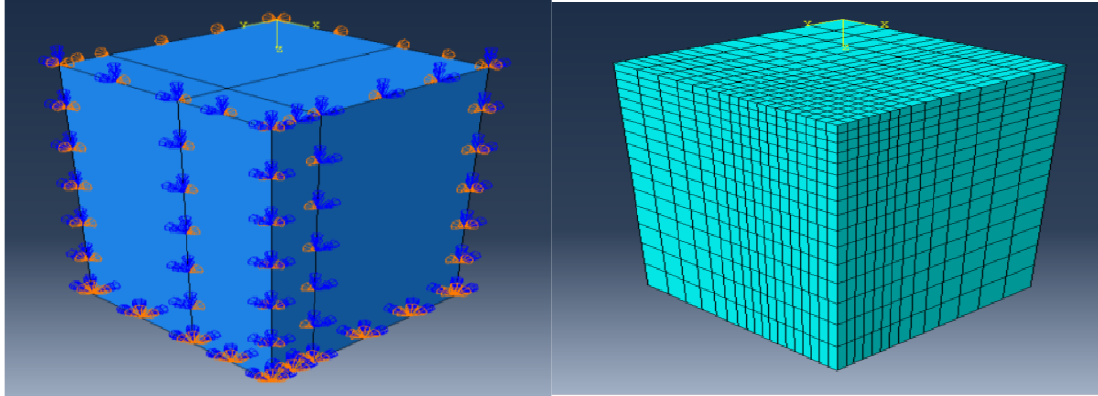
Figure 4: Finite element discretization and boundary condition selection of the footing model with